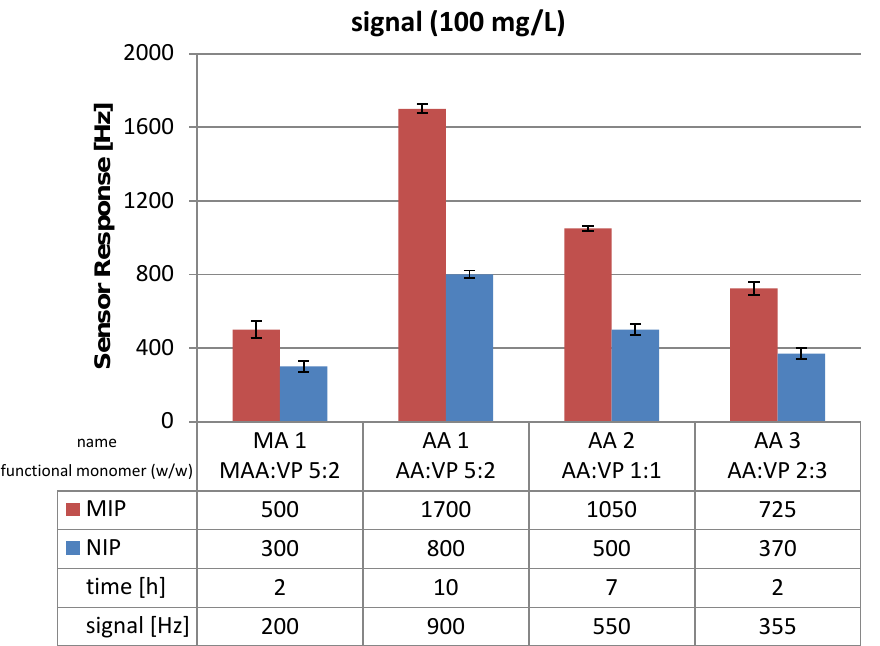
Figure 5. QCM sensor signals obtained for different ratios of functional monomers; cross linker 70%. The sensor signal shown is the difference in response between MIP and NIP.